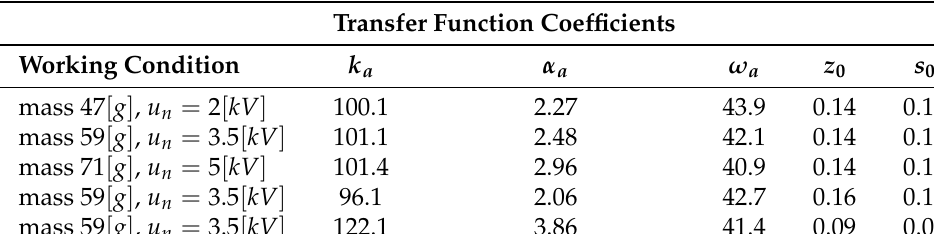
Figure 9. The step responses for various nominal voltages and mass loads. Table 2. The transfer function coefficients for various working conditions.